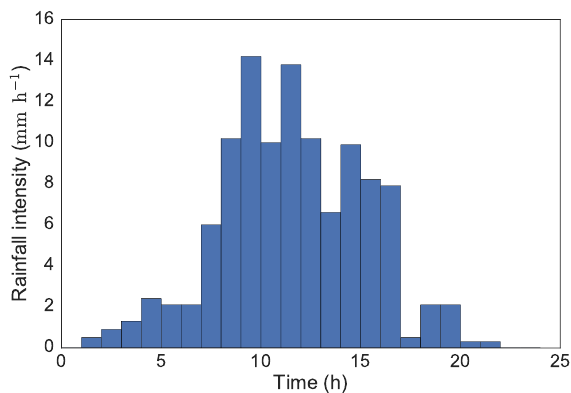
Figure 10. Hyetograph at the University of Hull.